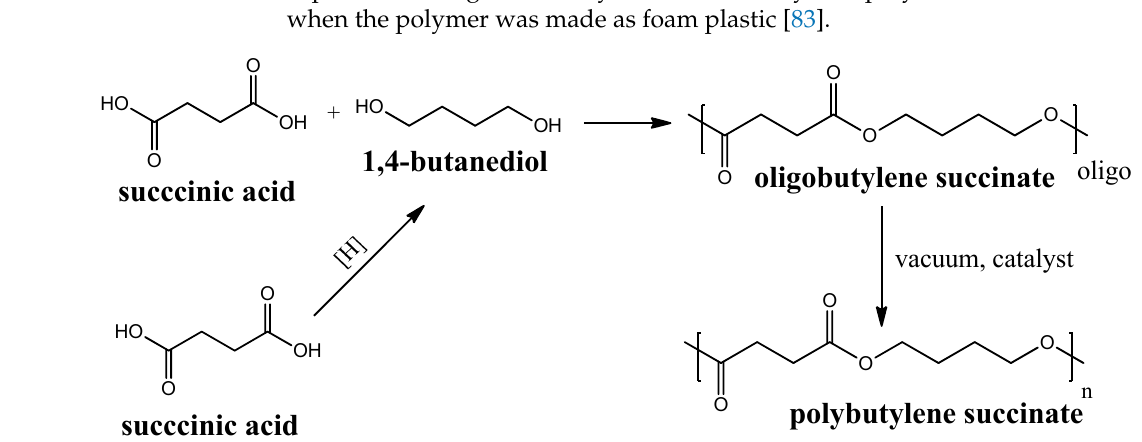
Figure 5. Circuit diagram of polybutylene succinate synthesis.